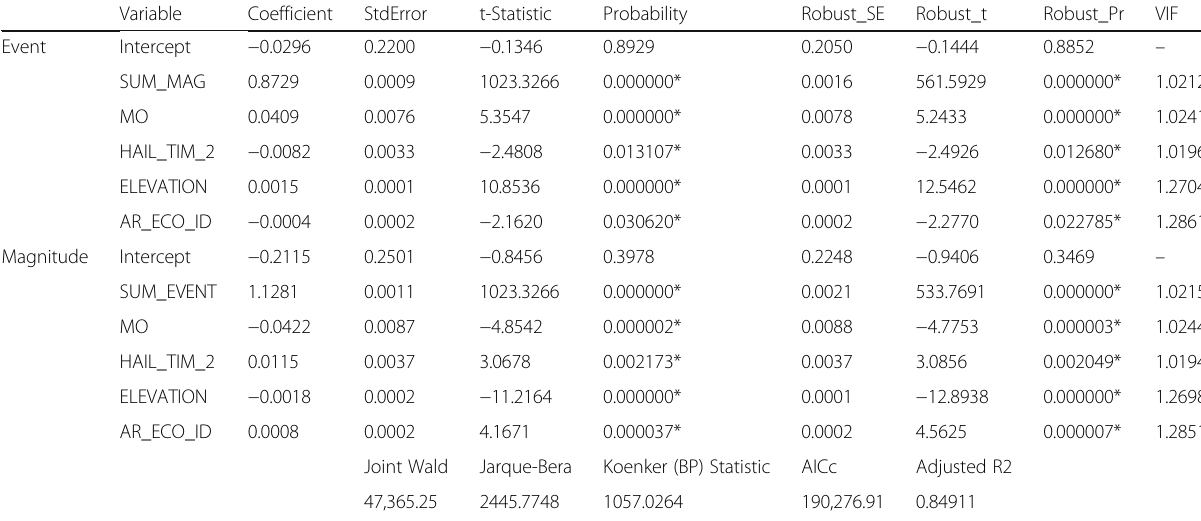
Table 3 Ordinary Least Squares results for hail